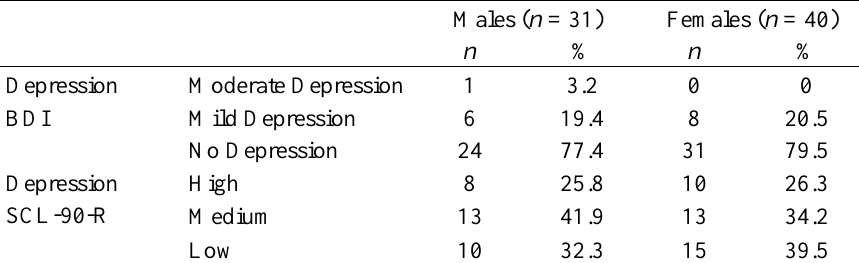
Levels of depression symptomatology in males and